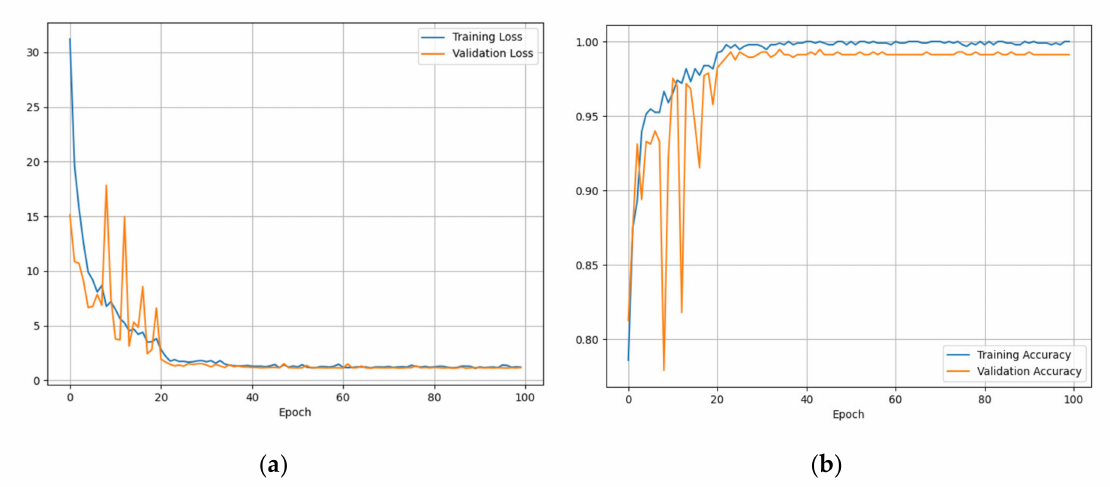
Figure 5. ( a ) Training and validation losses, ( b ) training and validation accuracy.